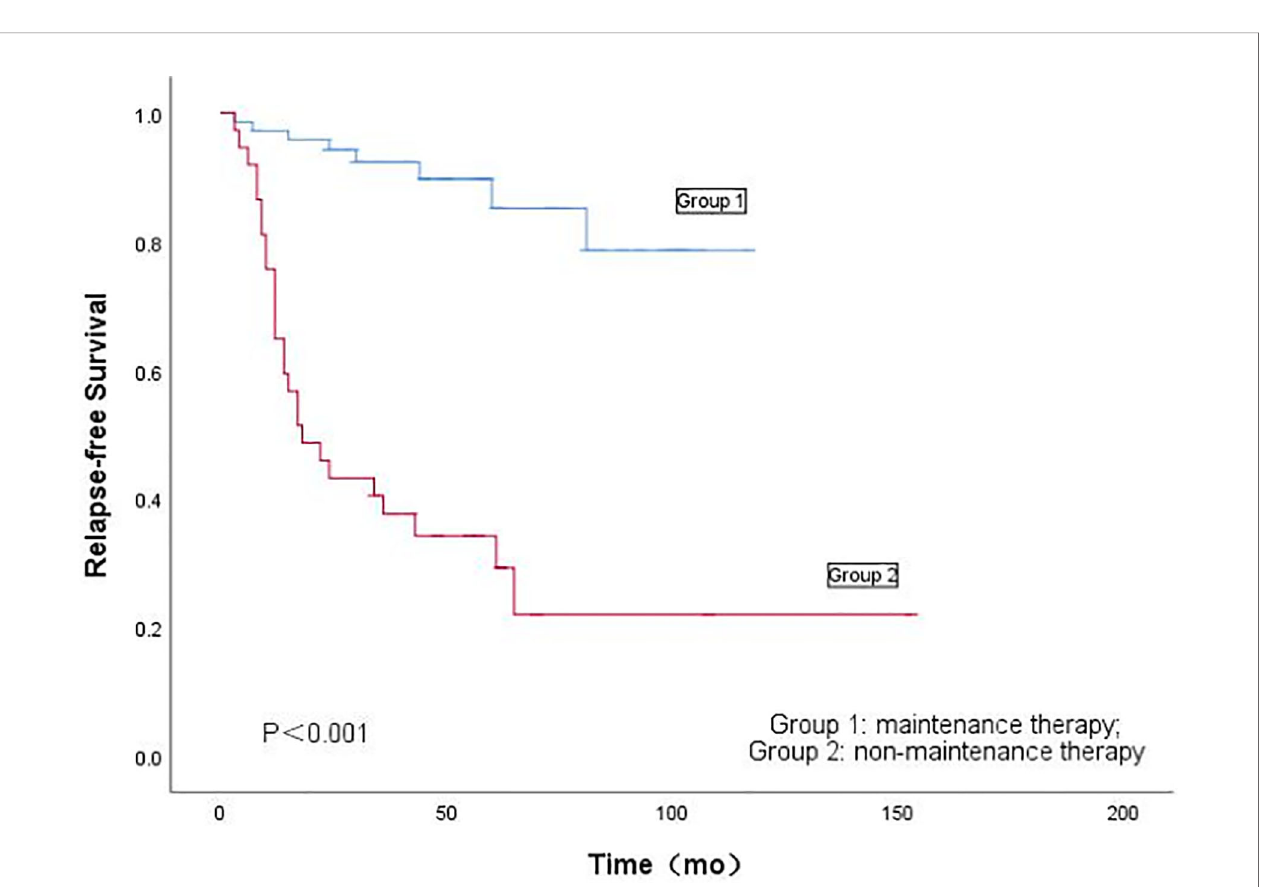
FIGURE 1 | Kaplan-Meier ’ s analysis of the effect of maintenance therapy on recurrence of fertility-preserving treatment for patients with atypical endometrial hyperplasia and endometrial